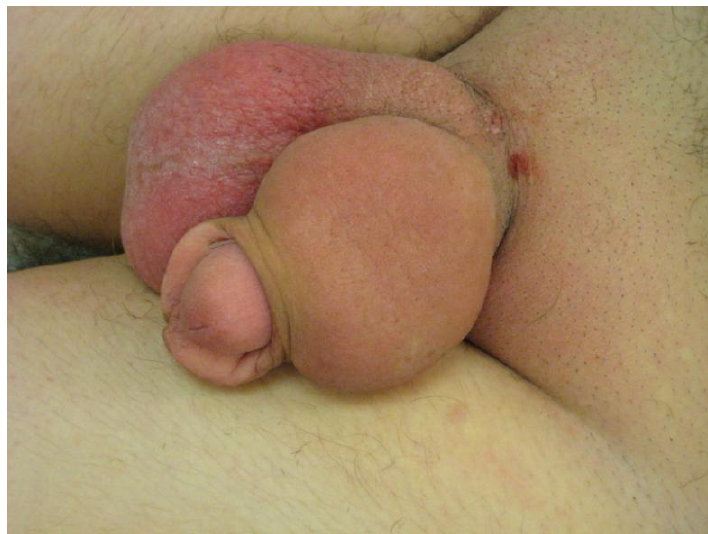
FIGURE 2 . An example of penoscrotal